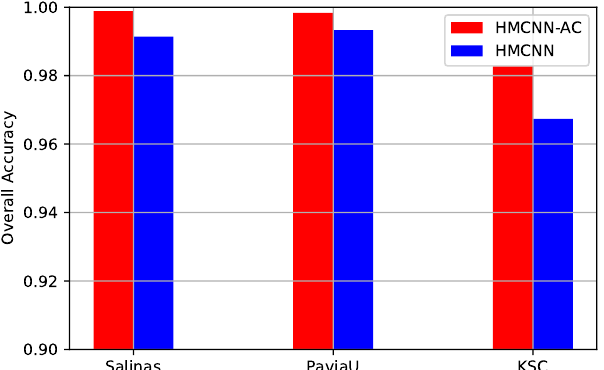
Figure 13. OAs comparison of HMCNN and HMCNN-AC on three datasets for effective analysis of auxiliary classifiers. For all three HSIs, OA value decreases for the constructed HMCNN framework, which confirms the effectiveness of the adopted auxiliary